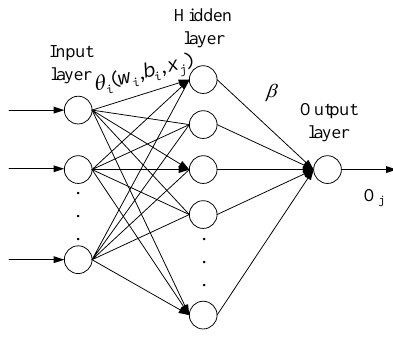
Figure 2. Structure of the single hidden layer feed-forward neural network.